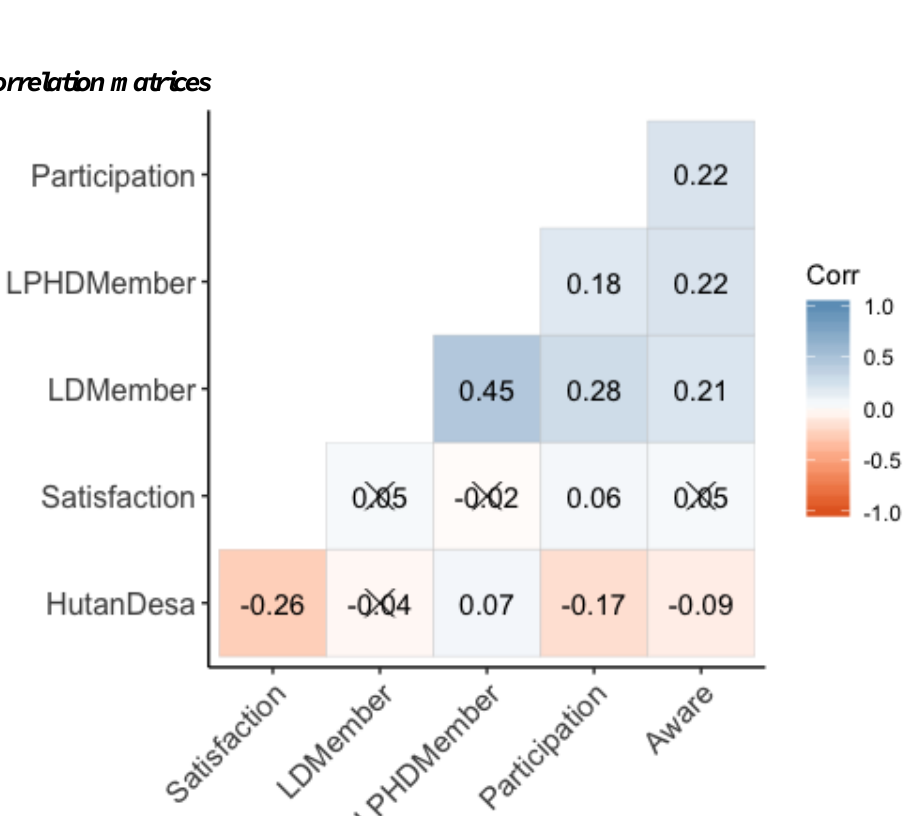
Figure A2.1. Correlation matrix to identify any existing relationships between Hutan Desa and participation variables. No strong correlations were identified. Of note, there is a positive correlation between member of any village institution (LD) and member of the Hutan Desa management committee (LPHD). We have excluded the LPHD variable from the analysis, because it is only relevant to those communities with Hutan Desa ; however, it there clearly is overlap between memberships of the two